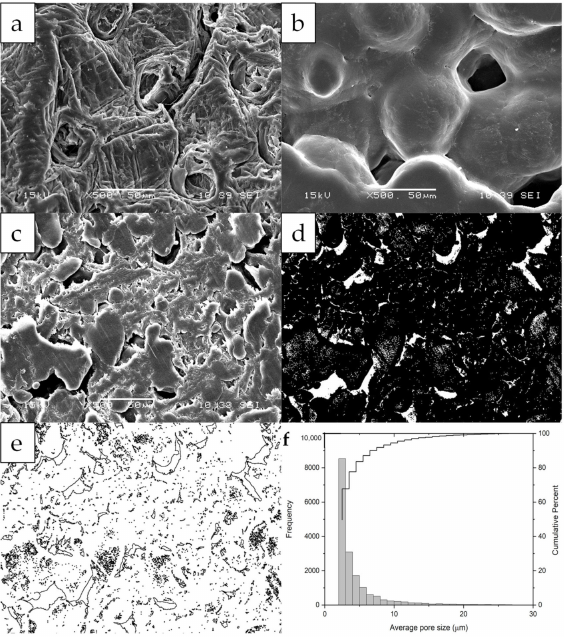
Figure 2. SEM micrographs for CS ( a ), PCL ( b ), MCP ( c ), binary image of MCP ( d ), analysis of particles by ImageJ ( e ) and average pore size distribution ( f